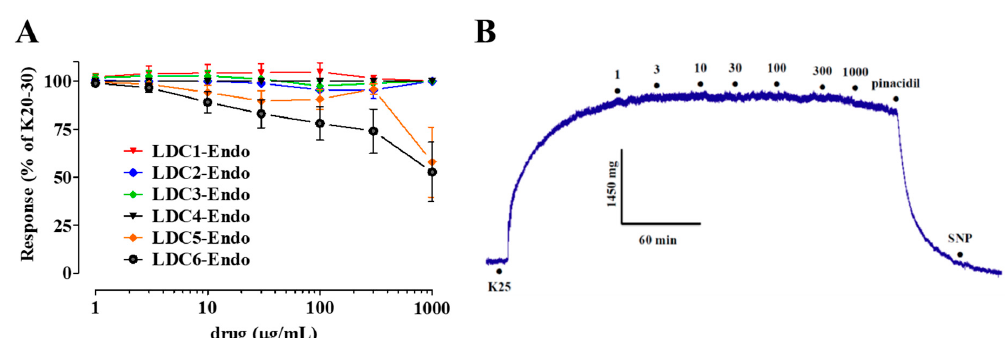
Figure 4. Effect of LDC extracts on high KCl-induced contraction of rat aorta rings. ( A ) Concentration- responsecurvesfor LDC extractswereconstructedonendothelium-denudedpreparationspre-contracted by 20–30 mM KCl. In the ordinate scale, relaxation is reported as percentage of the initial tension induced by KCl, taken as 100%. In the abscissa, the concentration of each drug (as specified in the legend to symbols) is reported in µ g / mL. Data points represent mean ± SEM ( n = 4–6). ( B ) Trace representative of 4 similar experiments, showing the effects of LDC1 ( µ g / mL) on an endothelium-denuded ring pre-contracted by 25 mM KCl (K25). The effect of 100 µ M pinacidil and 100 µ M sodium nitroprussiate (SNP) is also